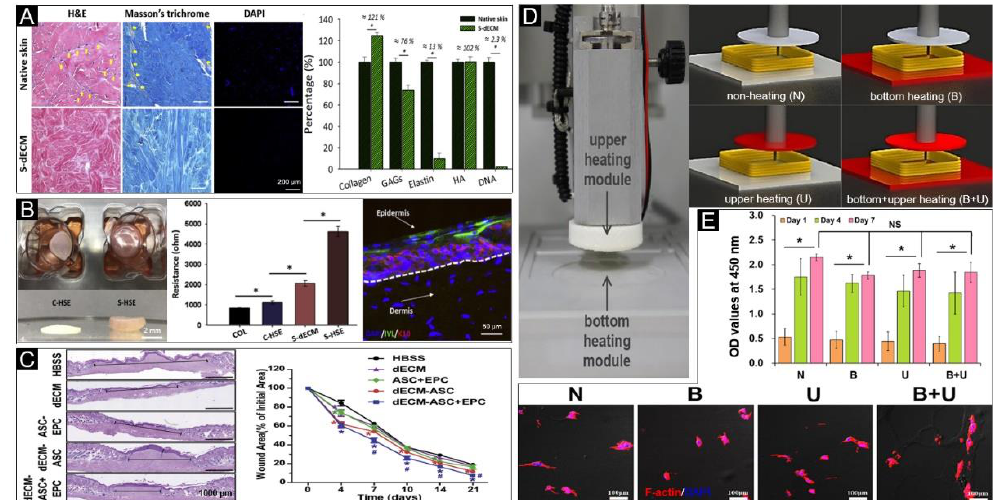
Figure 9. Decellularized extracellular matrix (dECM) bioink for skin bioprinting. ( A ) Qualitative analysis with H&E, Masson’s trichrome and DAPI staining (left) and quantitative analysis (right) of skin-derived dECM bioink, including collagen, GAGs, elastin, hyaluronic acid and DNA, which indicated that it successfully removes the cellular components from the native skin tissue. ( B ) Representative photographs (left) of 3D cell-printed in vitro skin equivalents, electrical resistance values for each group (S-HSE is the group using skin-derived dECM bioink, and the others are control group) (middle) and protein expressions (right) of the S-HSE group on day 10 after ALI culture. Involucrin (IVL): Early epidermal di ff erentiation marker; keratin 10 (K10): Late epidermal di ff erentiation marker. ( C ) Representative photographs of skin wound tissues on day 21 (wound gap, black lines exhibit distances between advancing edges of wounds) (left) and wound areas relative to the orginal ones, indicating the bioprinted skin based on dECM bioink accelerated wound healing. Reproduced with permission from [122]; copyright Elsevier, 2018. ( D ) Photographs of the upper and bottom heating modules installed in 3D printing equipment (left), and conceptual diagram of non-heating and heating conditions (right). ( E ) Qualitative (bottom) and quantitative (upper) analysis of cellular activities under di ff erent heating conditions. Reproduced from [23], under open access license.